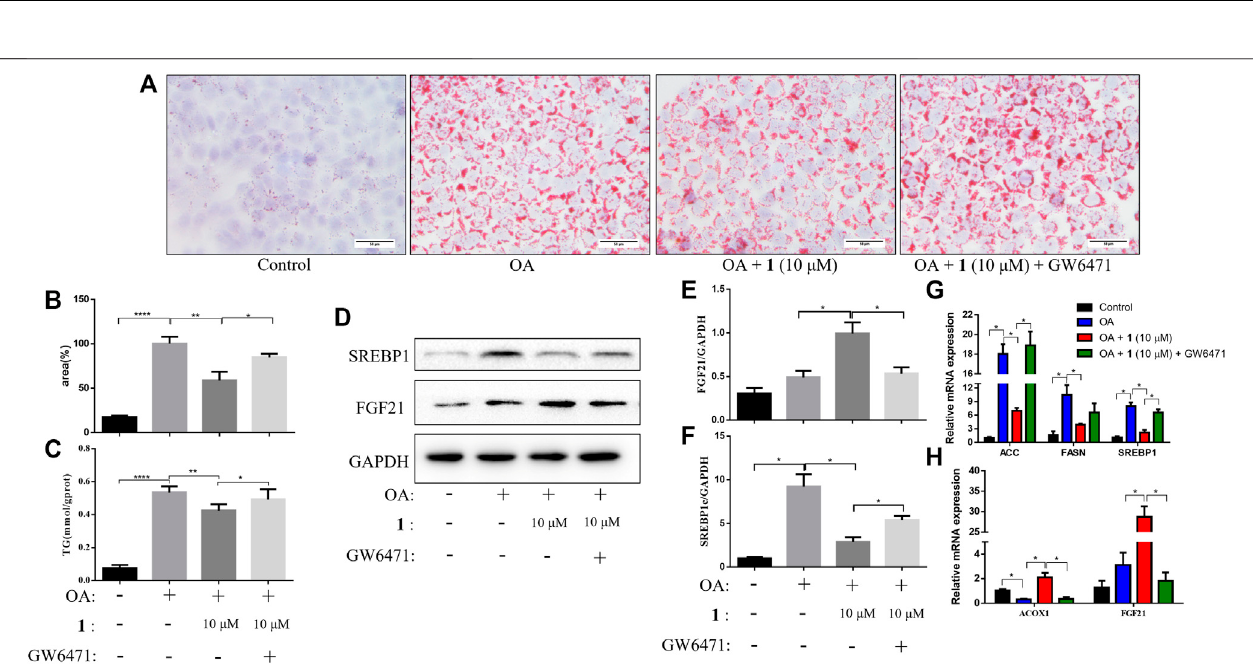
FIGURE 4 | PPAR α antagonist attenuates the effects of (+)-dehydrovomifoliol on OA-induced lipid accumulation in HepG2 cells. Before induction with oleic acid (OA) for 24 h, HepG2 cells were pretreated with 10 μ M GW6471 for 2 h and with 10 μ M compound 1 for 30 min. (A) Oil red O staining images (200 × ) and (B) the percentages of HepG2 cells containing lipid droplets. ( C ) Triglyceride (TG) levels were analyzed using the TG detection assay. (D , E , F) Western blotting analysis of SREBP1andFGF21proteinlevelsinHepG2cellsandquanti fi cationbydensitometricscanning. (G) , (H) mRNAlevelsof ACC , FASN , SREBP1 , ACOX1 ,and FGF21 were detected using RT-QPCR. Data shown in the bar chart are expressed as the mean ± SEM ( n (cid:2) 3). * p < 0.05, ** p < 0.01, **** p < 0.0001.